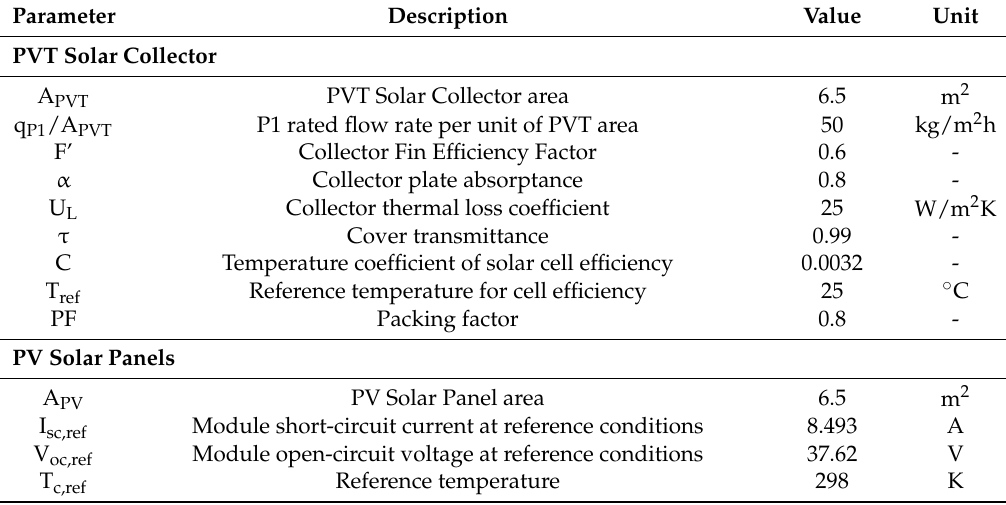
Table 1. Main parameters used in the